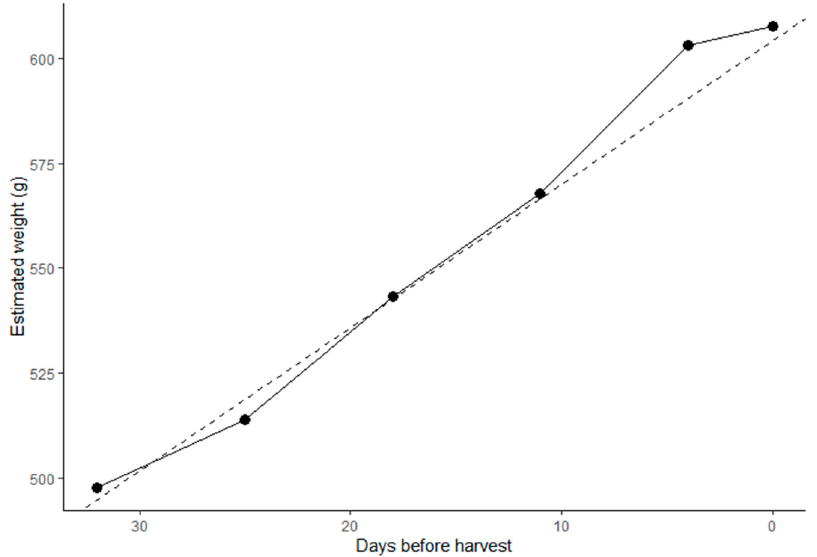
Figure 10. Fruit mass (g) estimated using lineal dimensions temporally up to harvest for mango, cv. Honey Gold. A linear regression model has been fitted to data between 32 and 11 days before harvest (dotted line): slope = 3.41 g/day, intercept = 604 g, R 2 = 0.99.